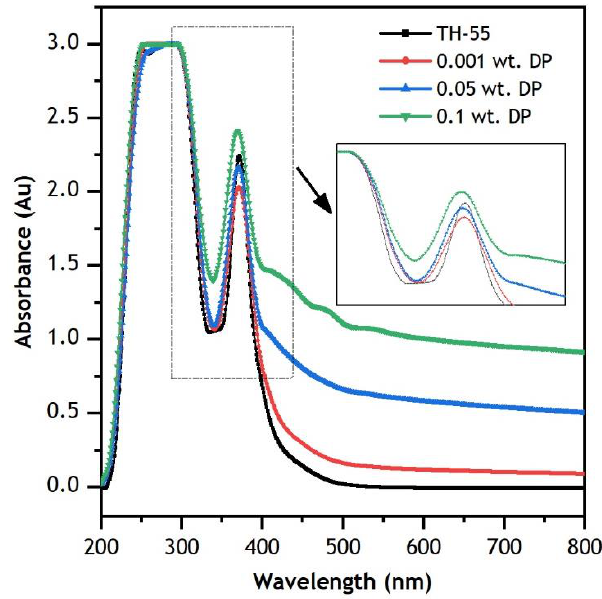
Figure 6. Optical UV − vis absorbance results of TH − 55 and TH − 55/DP nanofluids.